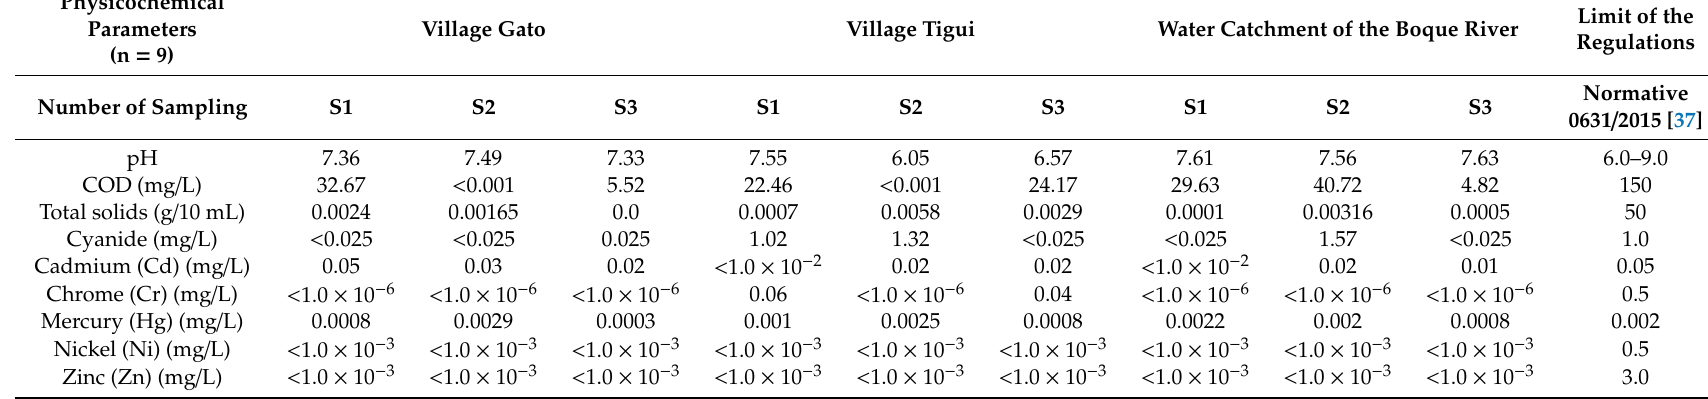
Table A1. Results of physicochemical parameter analysis compared with the normative 0631 / 2015.